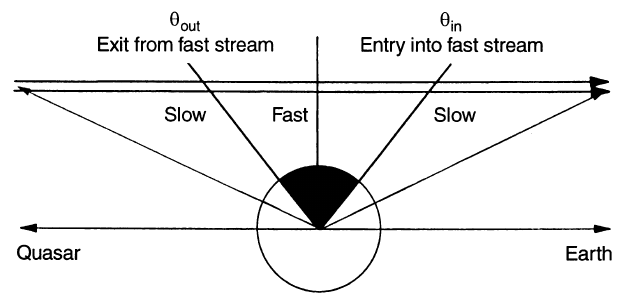
Fig. 3. Schematic diagram of IPS observations, showing the method used to de-convolve the contributions from di(cid:128)erent parts of the ray- path . The ray-path enters the fast stream when the angle along the ray-path is (cid:104) and leaves it at (cid:104) , where 0 (cid:176) angle is the point at which in out the ray-path is closest to the Sun. The scattering of radio waves from the quasar is considered as a series of thin-screen events, with the scattering parameters calculated every 5 (cid:176) along the ray-path. Fast and slow streams are treated separately, so the integration is performed for (1) distant slow stream ( (cid:104) : 90 (cid:176) (cid:21) (cid:104) > ), (2) fast stream out ( (cid:104) (cid:104) > ) and local slow stream ( (cid:104) (cid:179) (cid:104) > ) 90 (cid:176) out in in